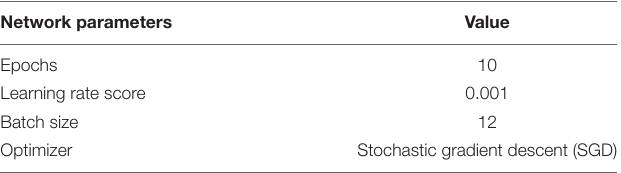
TABLE 2 | Description of framework hyper-parameters.